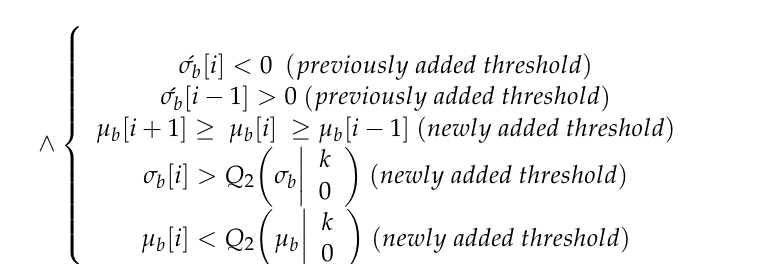
Figure 7. By deploying the new sets of thresholds in order to filter the redundant frames,